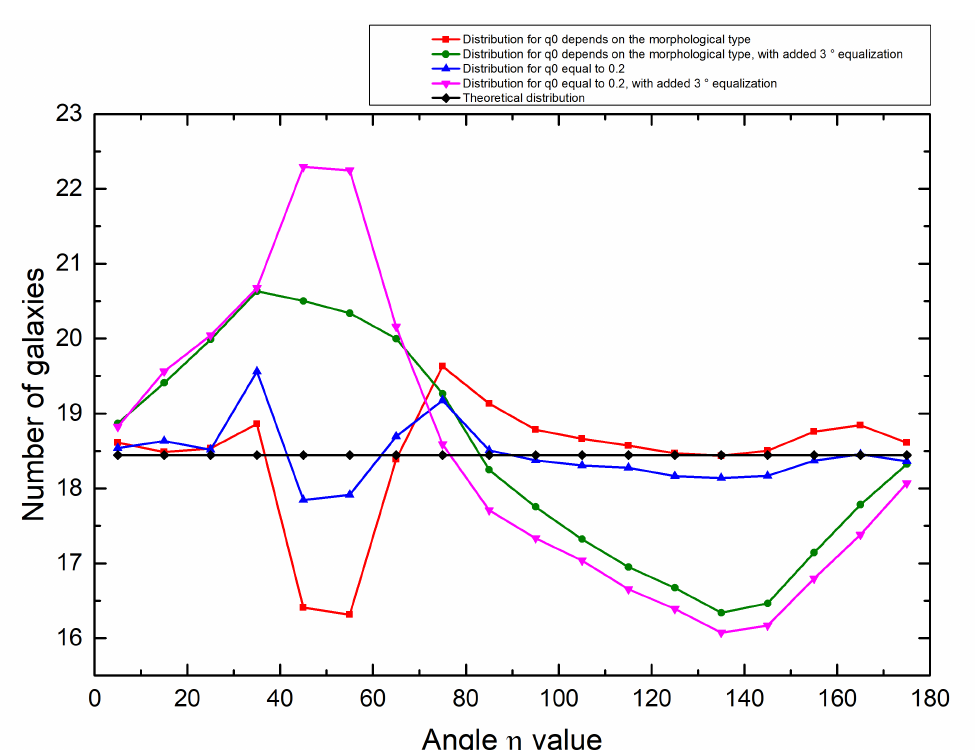
Figure 4. Simulated distributions of the angle η for group